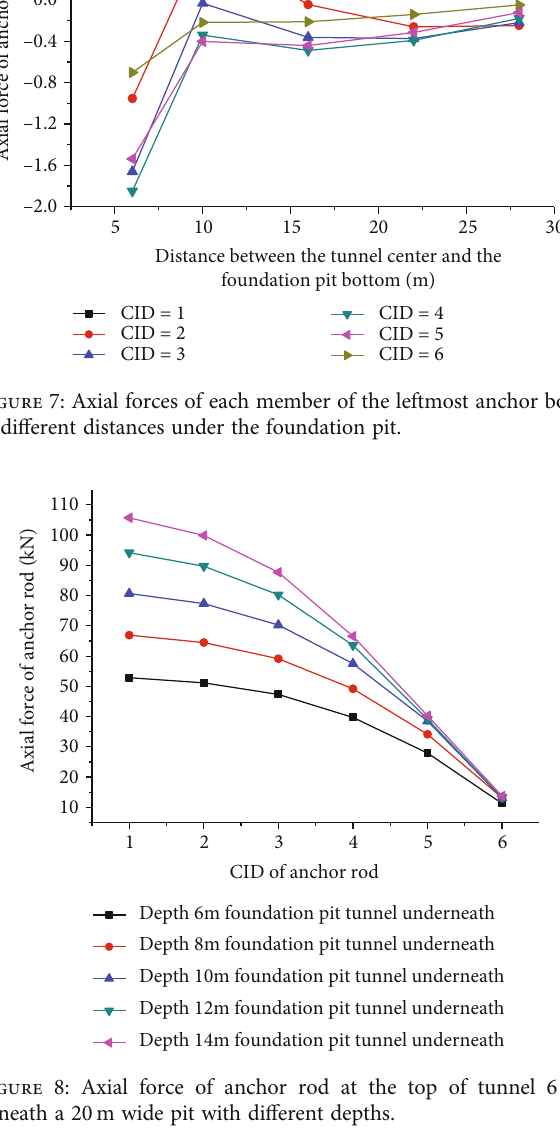
Figure 10: Axial force of tunnel anchor bolt under 10 m deep foundation pit with di ff erent